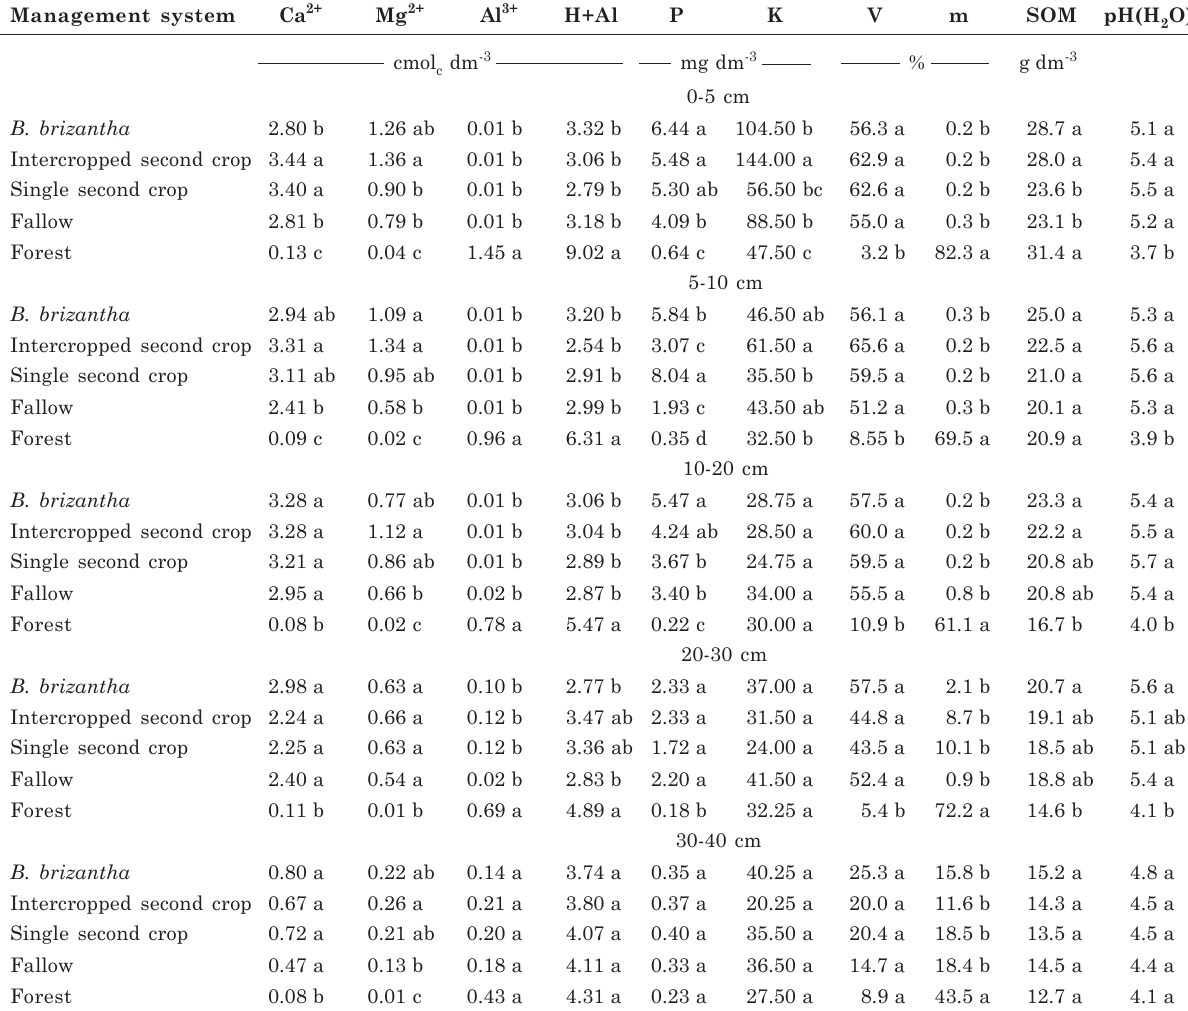
Table 3. Chemical properties and soil organic matter (SOM) content of the dystrophic Red Latosol at five depths under different soil use and management systems during the between-crop season of soybean